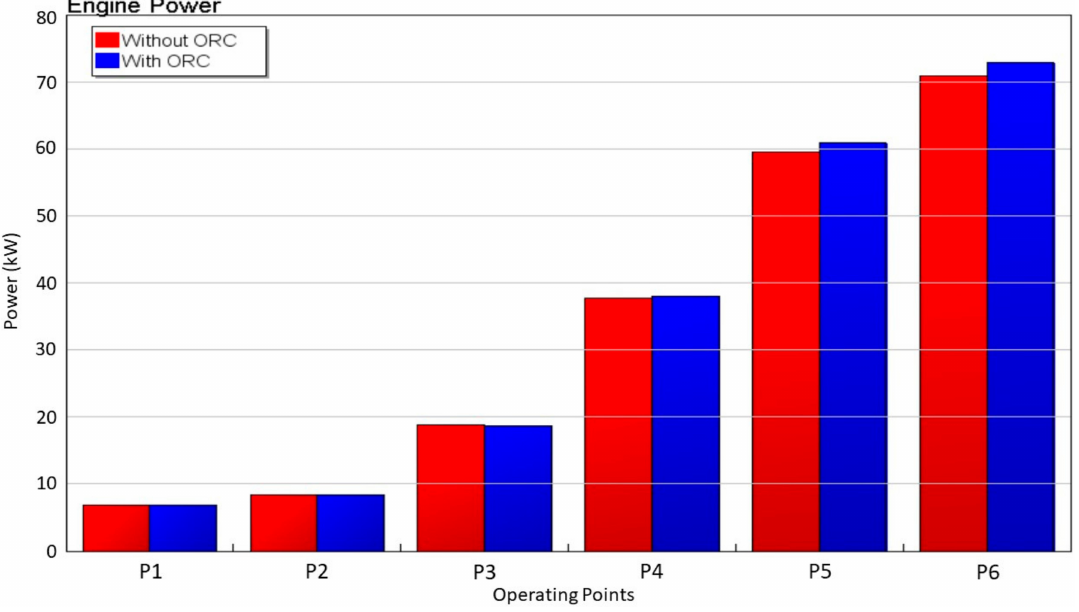
Figure 27. Comparison of Power Generated by the